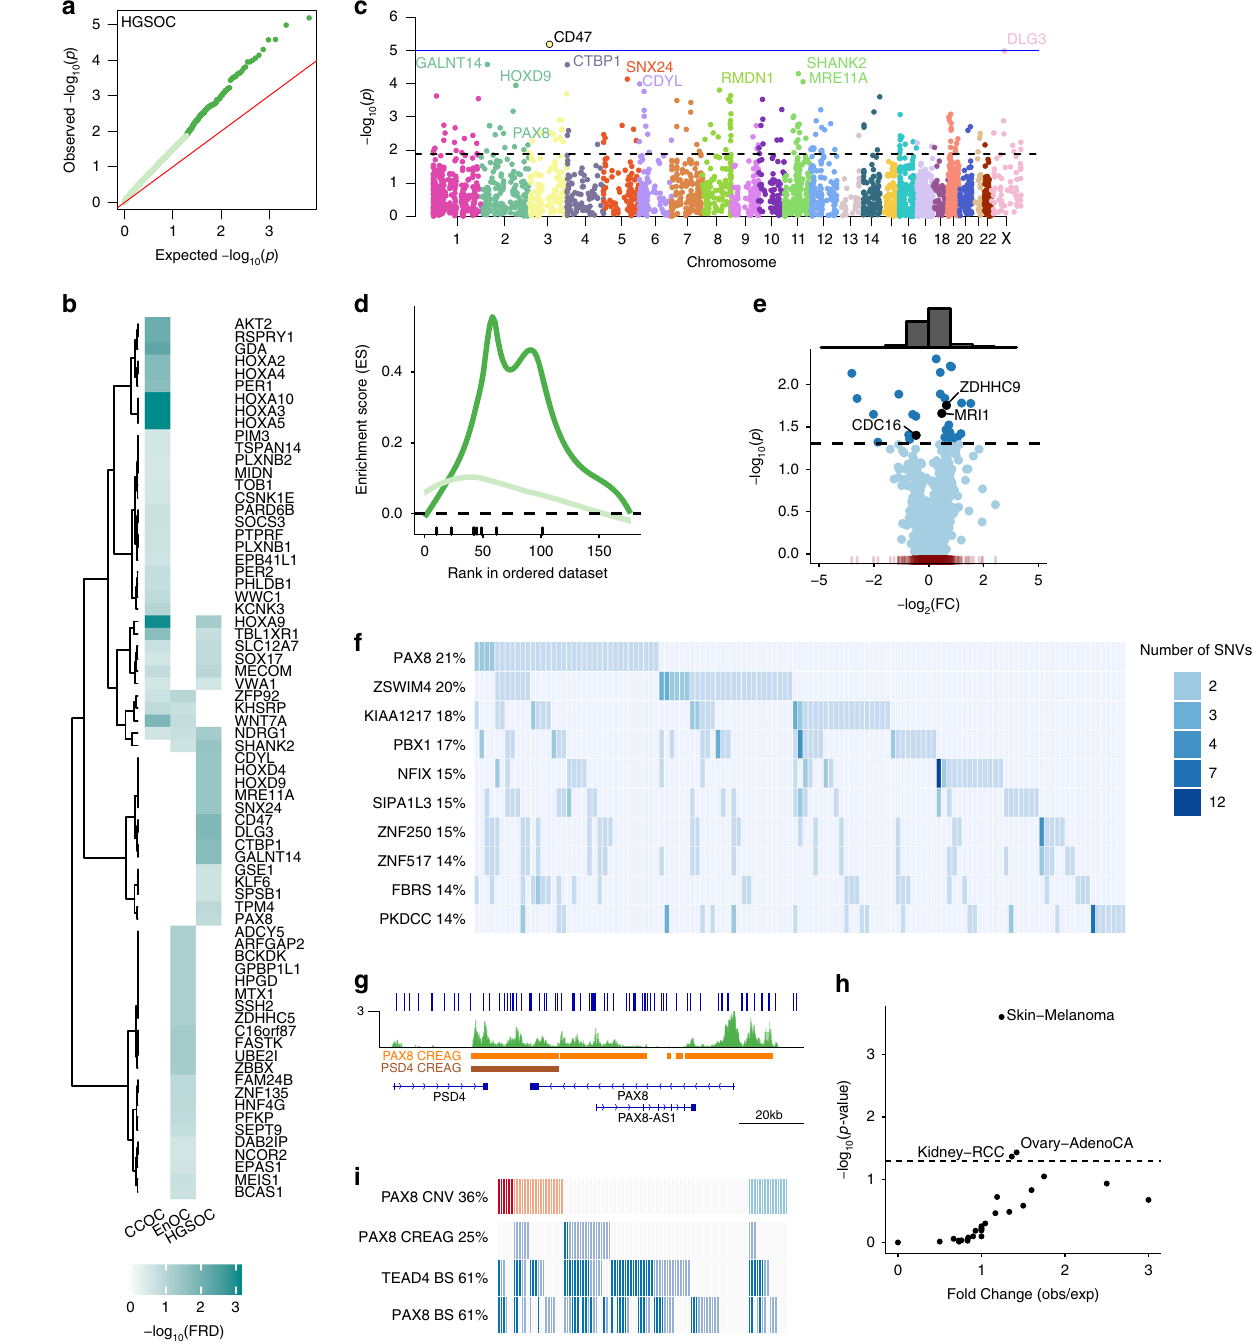
Fig. 4 Gene-centric mutation rate aggregated across the collection of REs associated to a gene (CREAG). a QQ-plot that shows the expected ( x -axis) and observed ( y -axis) signi fi cance values of mutational burden for all CREAGs. b Super-enhancer associated genes that have somatic SNVs. c Manhattan plot showing the genomic location ( x -axis) and signi fi cance ( y -axis) of mutational burden for all CREAGs. d Enrichment of super-enhancer associated genes in FM CREAGs (dark green) vs. random selection (light green) ( P GSEA = 0.01). e Volcano plot showing the fold change of median gene expression ( x - axis) and the signi fi cance value ( y -axis) of the putative target gene in samples with single nucleotide variants in a CREAG vs. wild-type samples. The histogram on top of the scatterplot shows more overexpression events ( − log2(FC)> 0) in the presence of single nucleotide variants than under expression events ( − log2(FC) < 0). f HGSOC ( n = 169) non-coding oncoplot showing the top 10 ranking genes in terms of number of samples with mutations overlapping its CREAG. g PAX8 locus showing the mutations within the PAX8 CREAG. h The number of samples with mutations overlapping the PAX8 CREAG are statistically signi fi cant in Skin-Melanoma, Ovary-Adeno-CA and Kidney-RCC datasets. i HGSOC ( n = 110) oncoplot with PAX8 copy number variation, PAX8 CREAG mutation, TEAD4 and PAX8- binding site